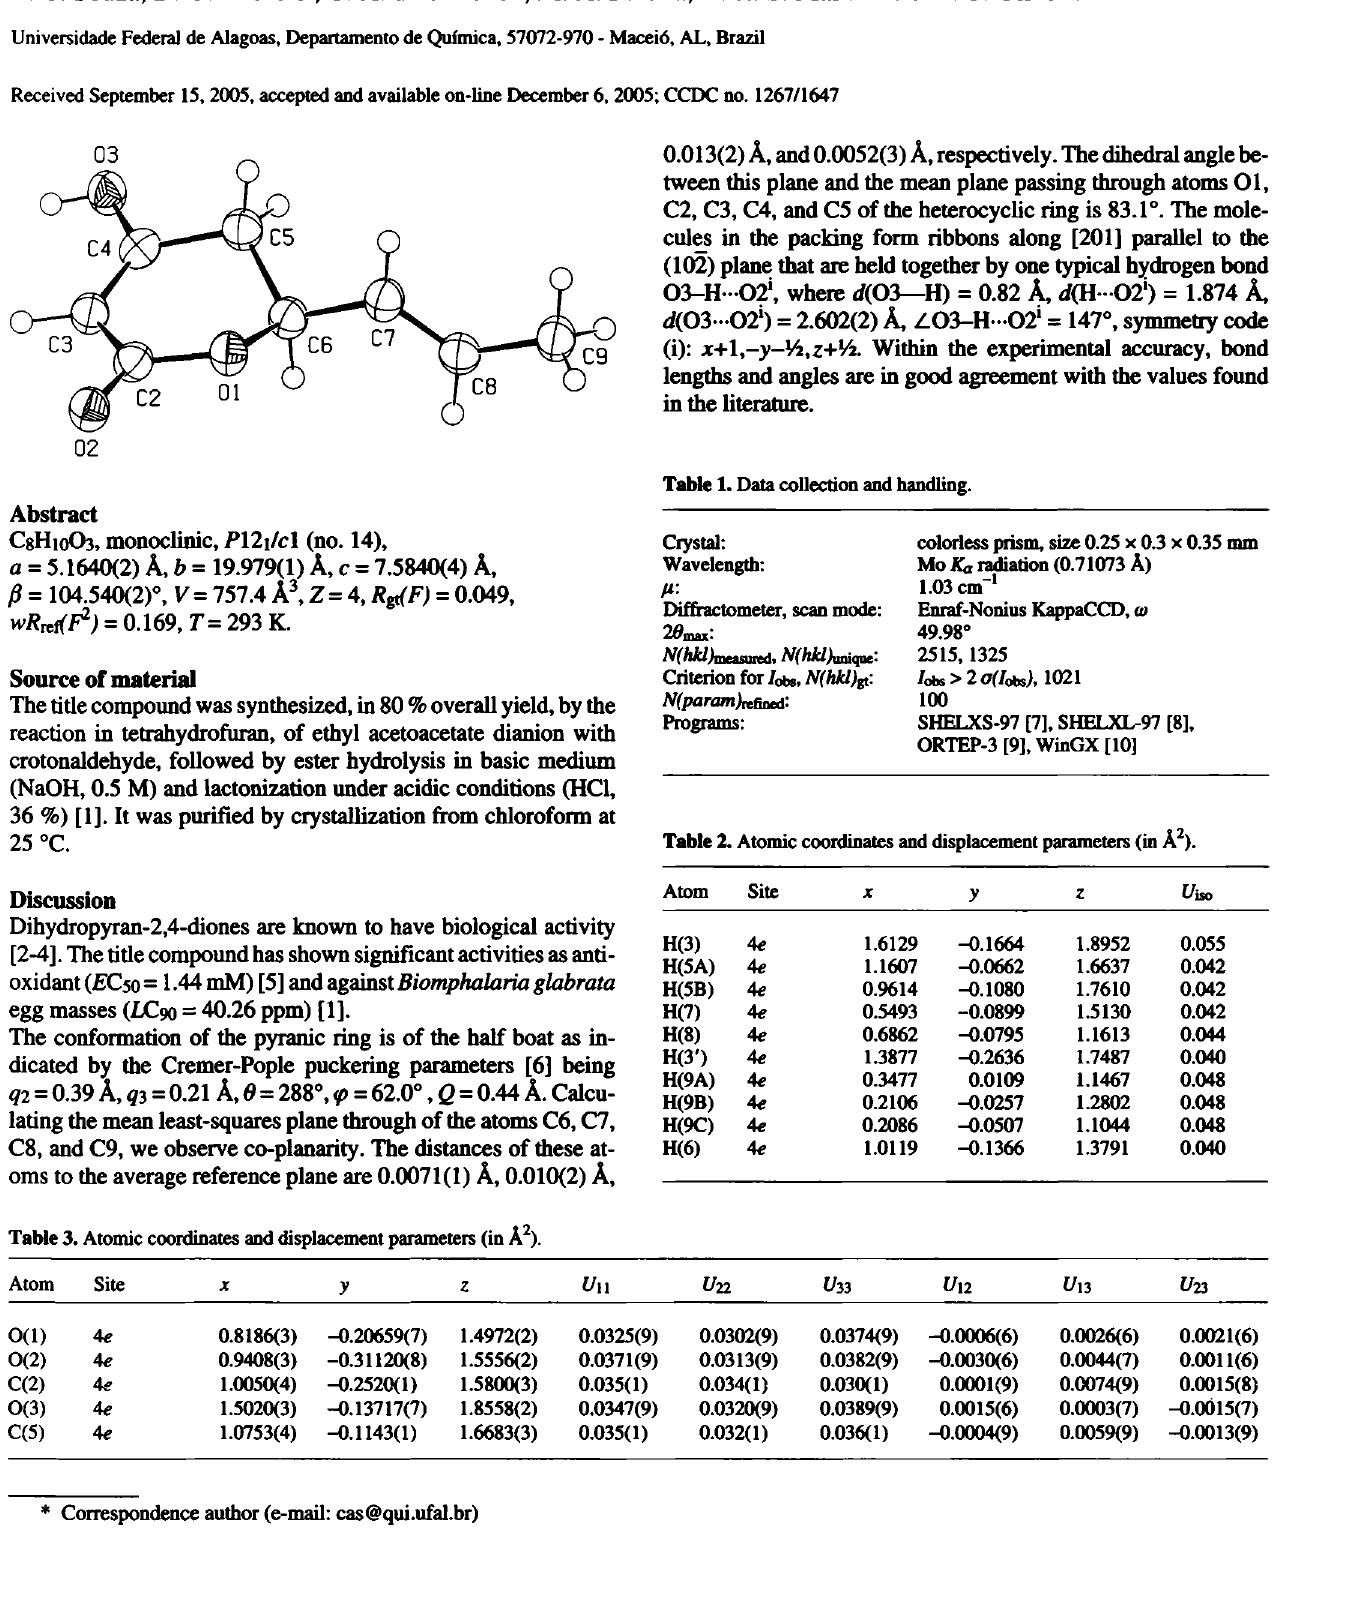
Table 3. Atomic coordinates and displacement parameters (in A 2